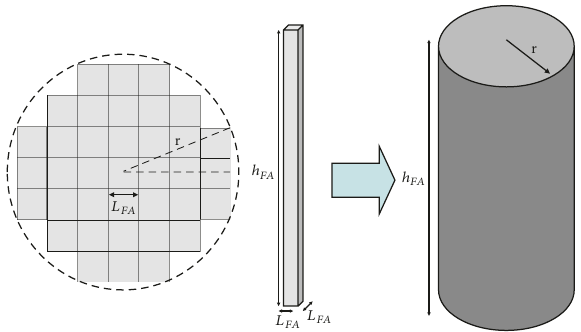
Figure 6: Approximate model of the radioactive source inside the